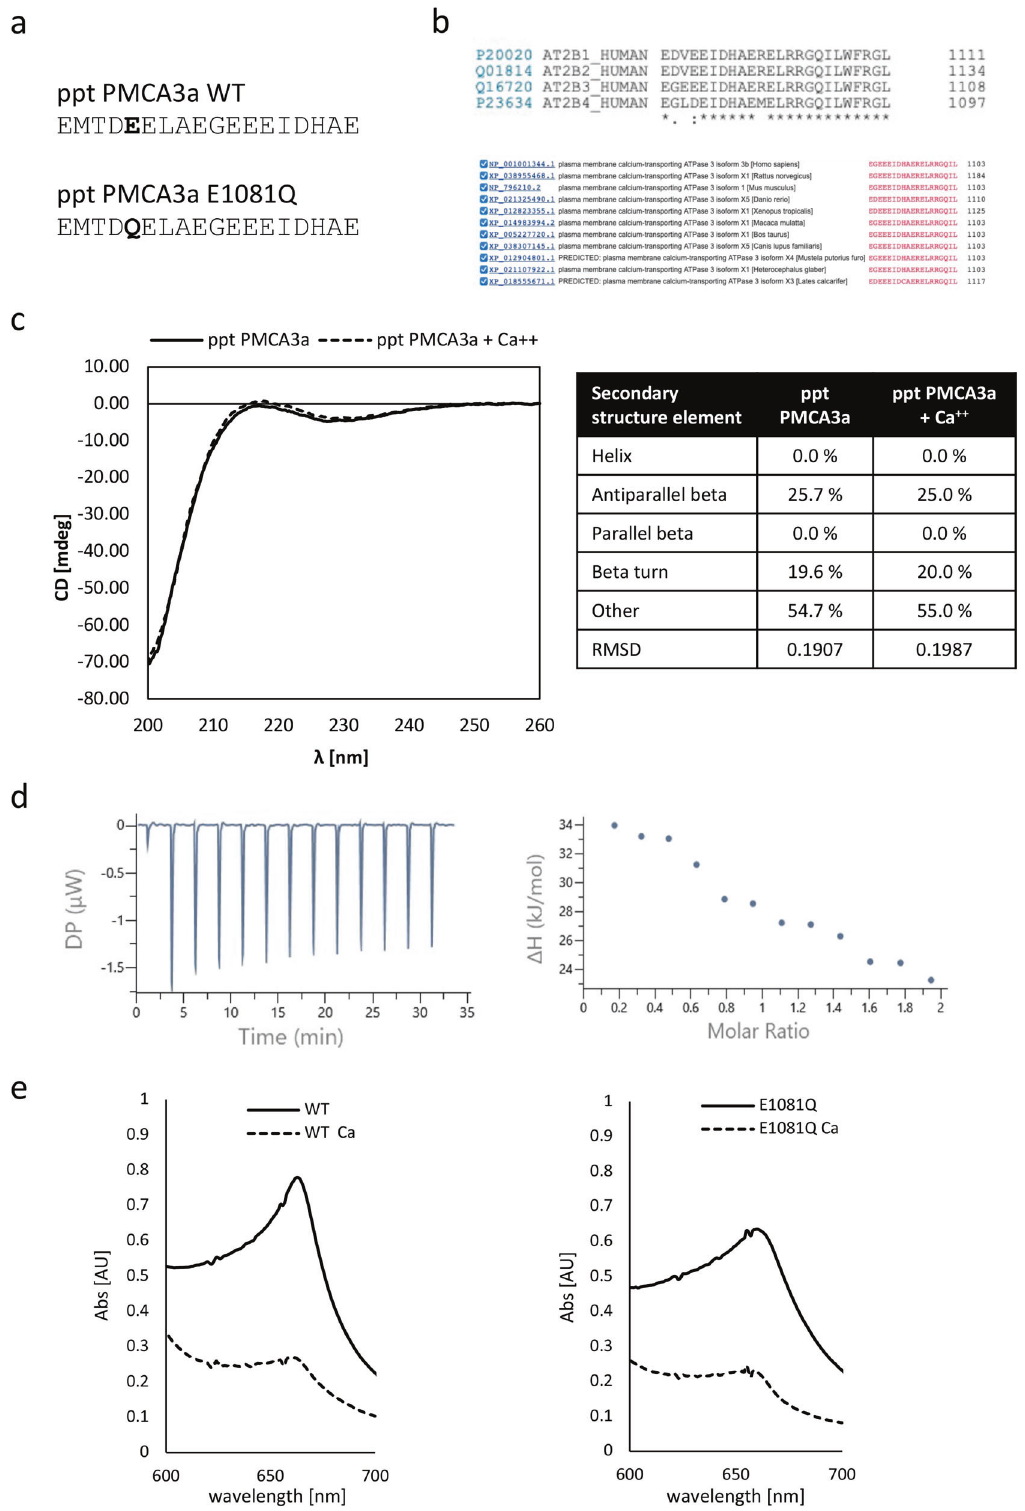
Fig. 5 PMCA peptides-Ca 2 + interaction studies. a Amino acidic sequences of wild-type PMCA3a 18mer (A18 [32]) and E1081Q mutant peptides, exploited for Ca 2 + studies. b Sequence alignment showing the conservation of the residues around the mutated region among PMCA3 isoforms (1 – 4) and species. c Far UV CD spectra (left panel) of A18 peptide in absence (solid line) and presence (dashed line) of 1 mM free Ca 2 + , and their respective deconvolution (right panel) with the estimated secondary structure. d ITC raw (left panel) and blank-subtracted processed (right panel) data of peptide A18 - Ca 2 + binding experiment. No fi tting model was able to identify reasonable binding. e Absorbance spectra of Stains-all samples of A18 (left panel) and E1081Q mutant peptides (right panel) in the absence (solid line) and presence (dashed line) of 1 mM free Ca 2 + .